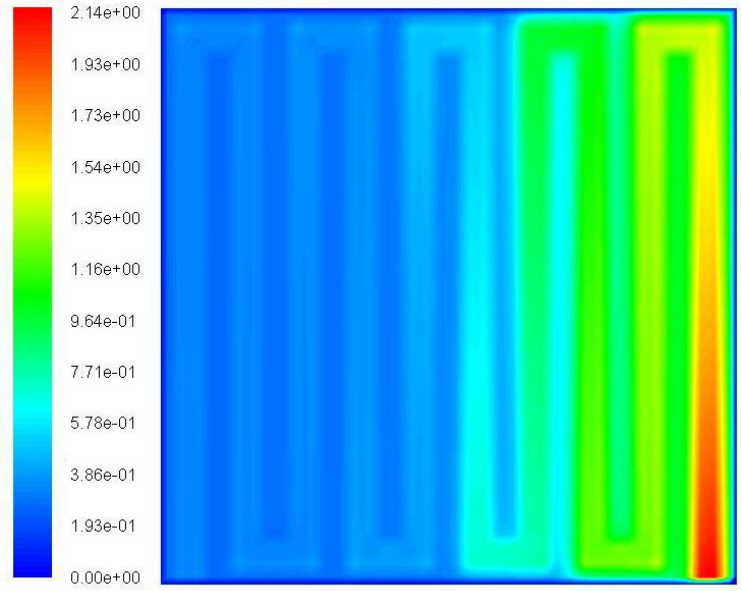
Figure 3. Distribution of K(x,y)/K FLUENT PEMFC